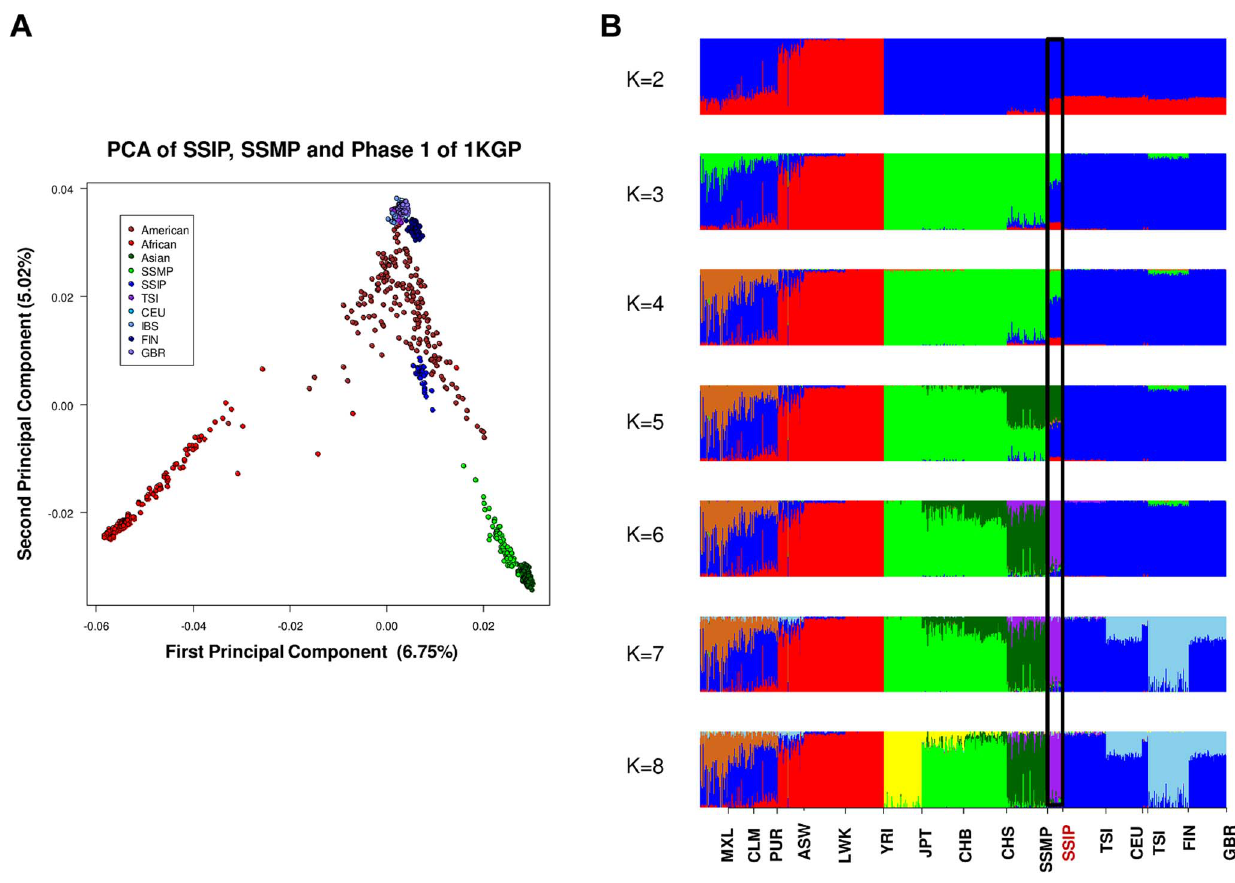
Figure 3. Principal component analysis (PCA) of 1,224 samples from 16 global populations. PCA of 1,224 samples from SSIP, SSMP and 14 populations from Phase 1 of the 1 KGP, where the samples are grouped and color-coded by continents (panel A). An analysis of admixture was also performed on the 16 populations with ADMIXTURE, where the number of distinct populations ( K ) was allowed to vary between 2 and 8 (panel B). The black window highlights the position of the SSIP samples on the admixture plot.